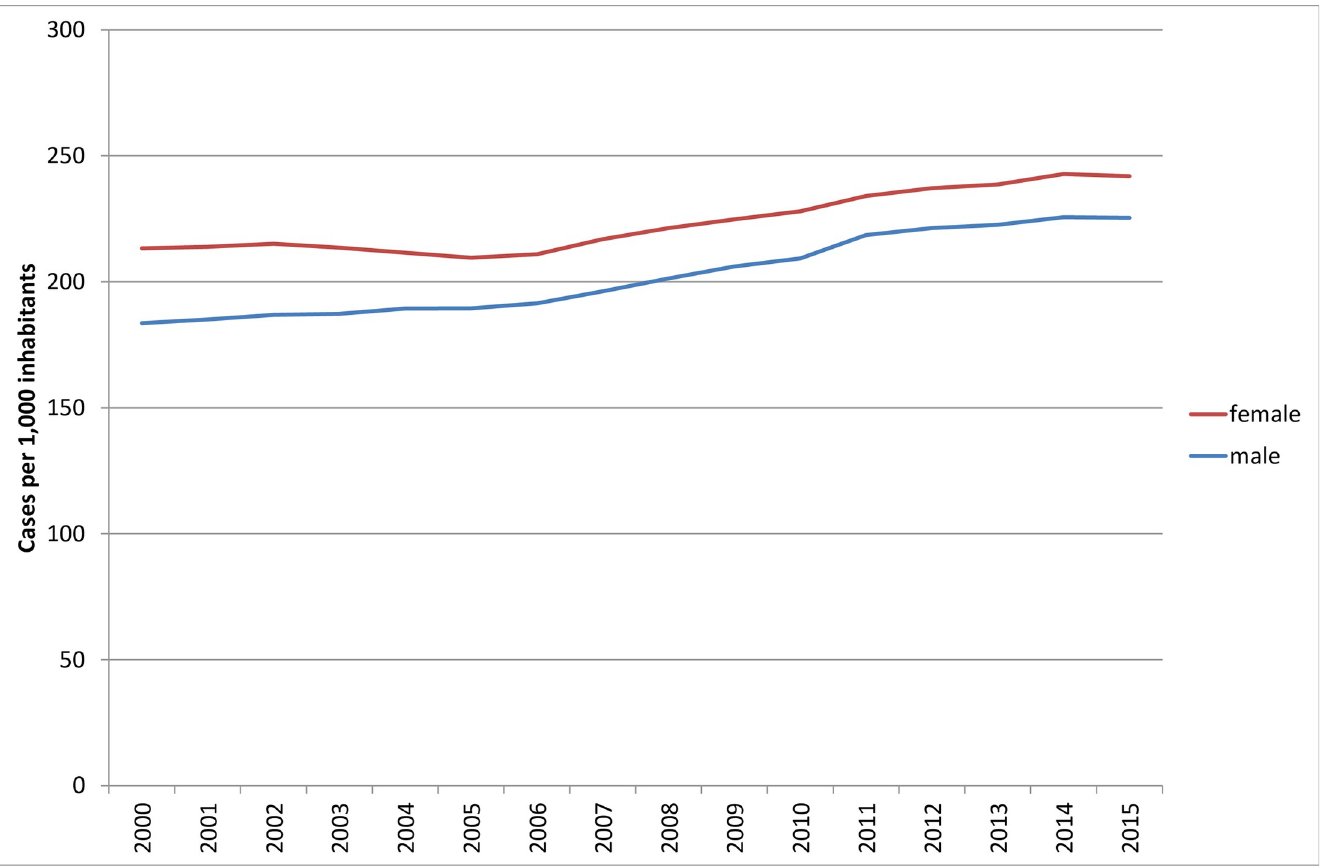
Fig 2. Hospitalization rates (hospital cases per 1,000 inhabitants), 2000 to 2015. Source: Hospital statistics 2000–2015 [19].